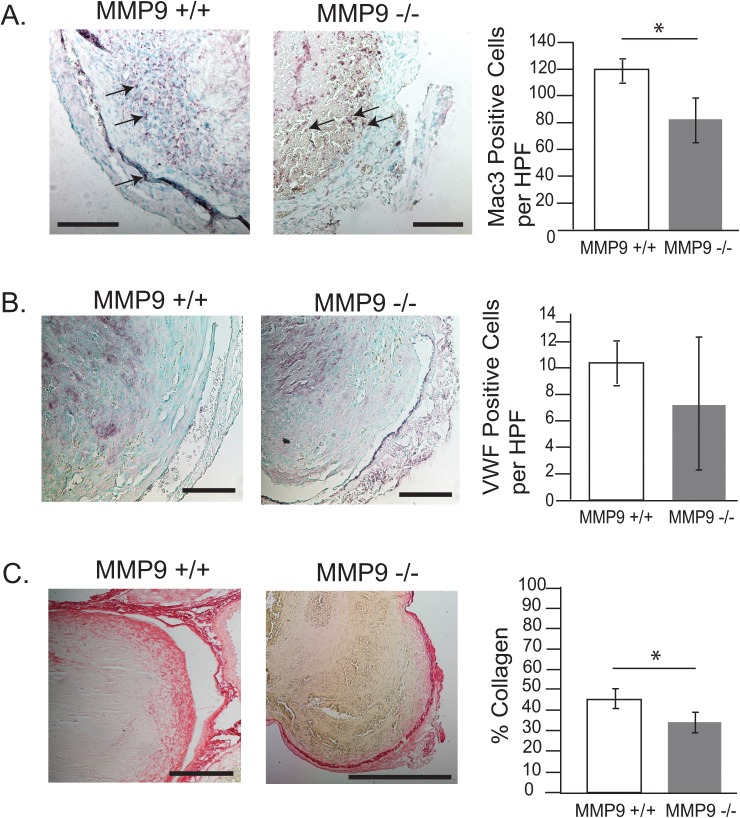
Immunohistochemical analysis of DVT in MMP-9+/+ and MMP-9-/- mice.MMP-9 effects on thrombus cellularity and collagen. Macrophage counts (MMP-9+/+ 121±11, N = 4 versus MMP-9-/- 85±18, N = 6; *p<0.05) (arrows indicate macrophages) (A), endothelial cell counts (MMP-9+/+ 10.7±2, N = 3 versus MMP-9-/- 8.8±5, N = 5, p = 0.53) (B) and collagen content (MMP-9+/+ 45±5%, N = 4 versus MMP-9-/- 34±4%, N = 6, *p<0.05) (C) in thrombi from MMP-9+/+ and MMP-9-/- mice are shown on day 12 after IVC ligation. Six high powered fields (HPF) were evaluated per N and scale bar measures 100 uM.